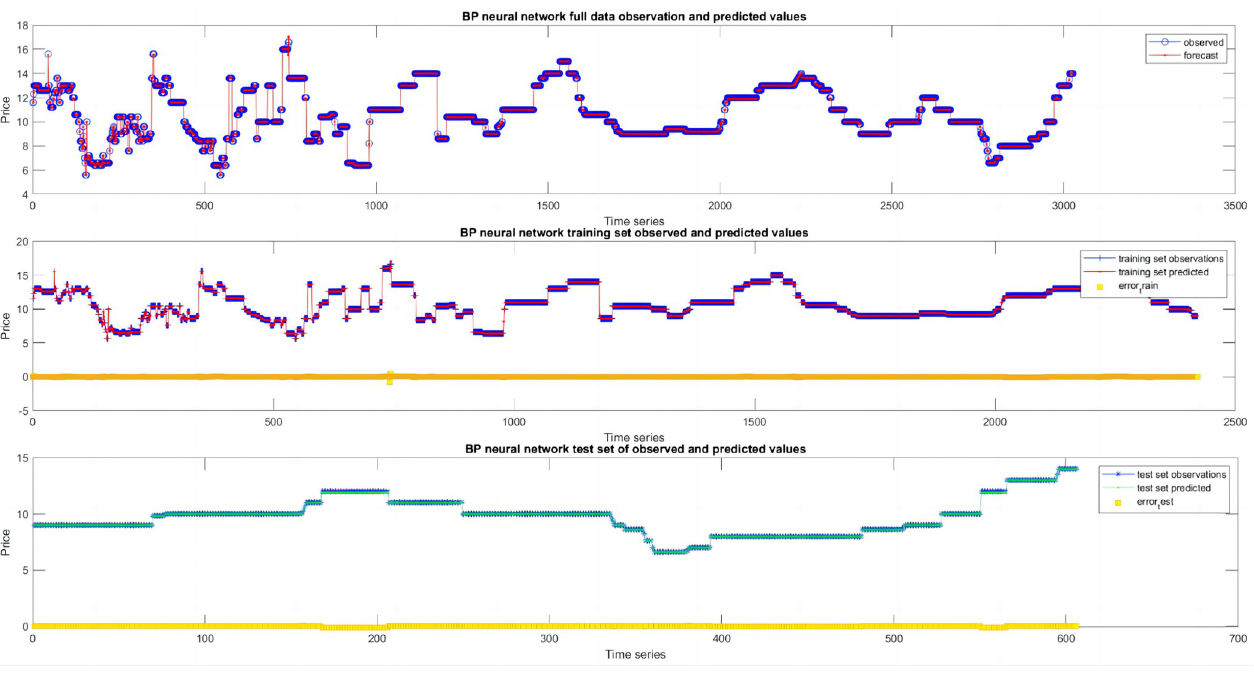
Fig 4. Combined observed and predicted values of the back-propagating neural network.